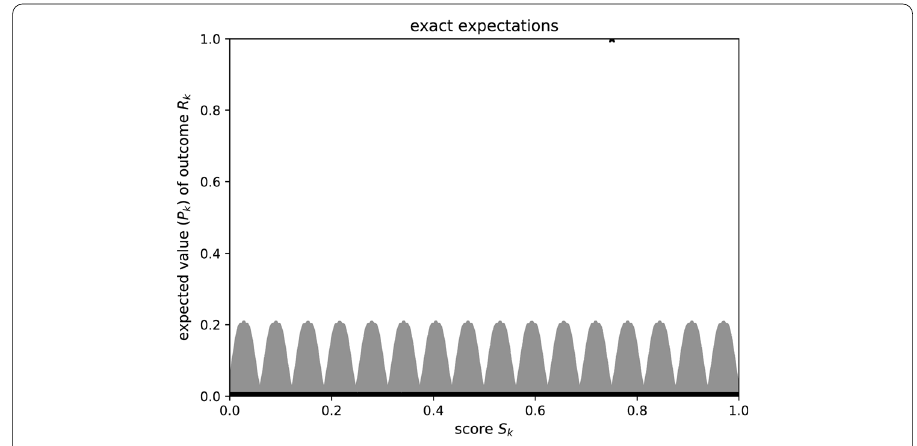
Fig. 8 Ground-truth reliability diagram for Fig.